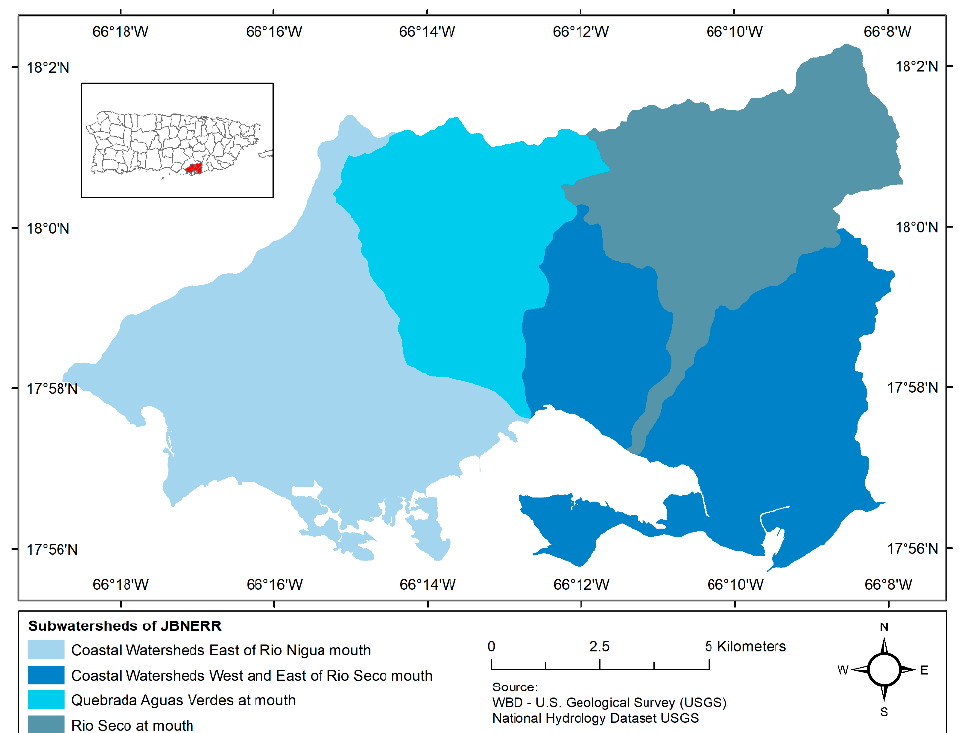
Figure 1. Study area JBNERR watershed delimitation.